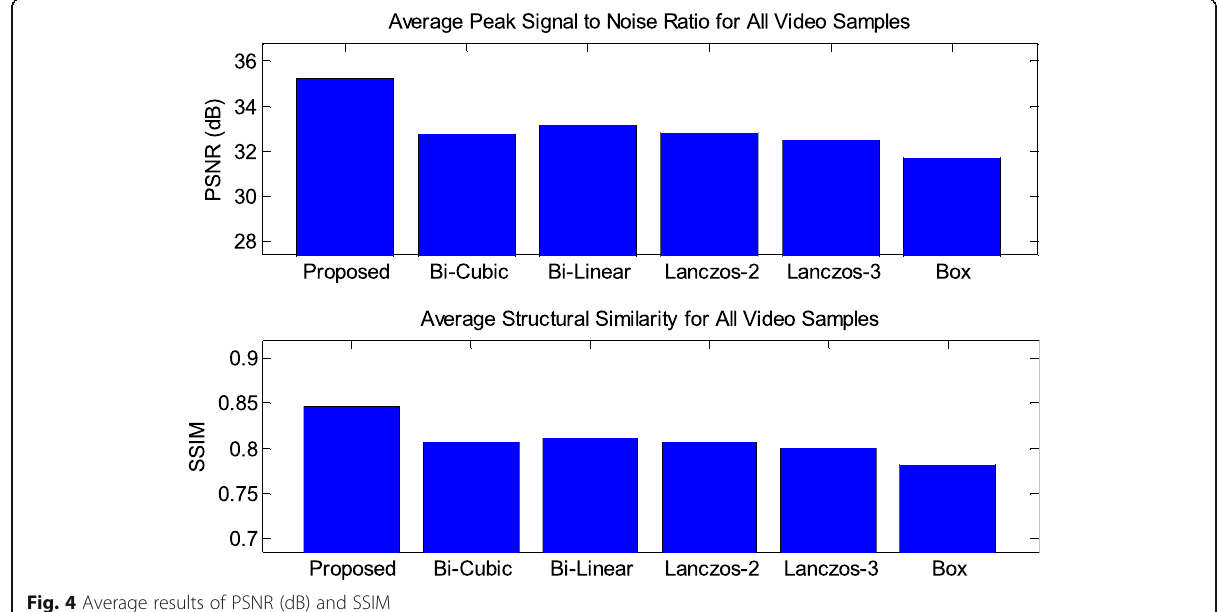
Fig. 4 Average results of PSNR (dB) and